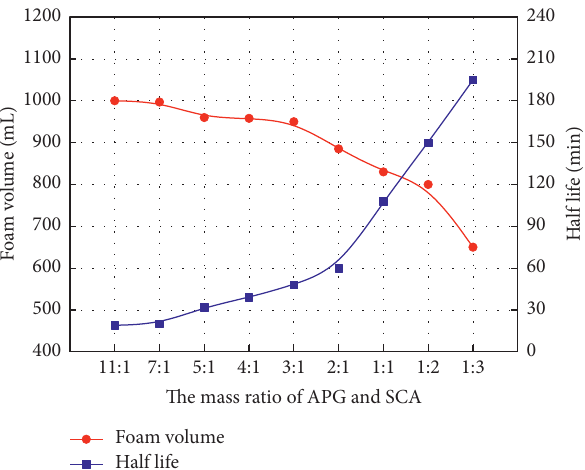
Figure 3: The curve of foaming volume and half-life under different surfactant mass ratios.